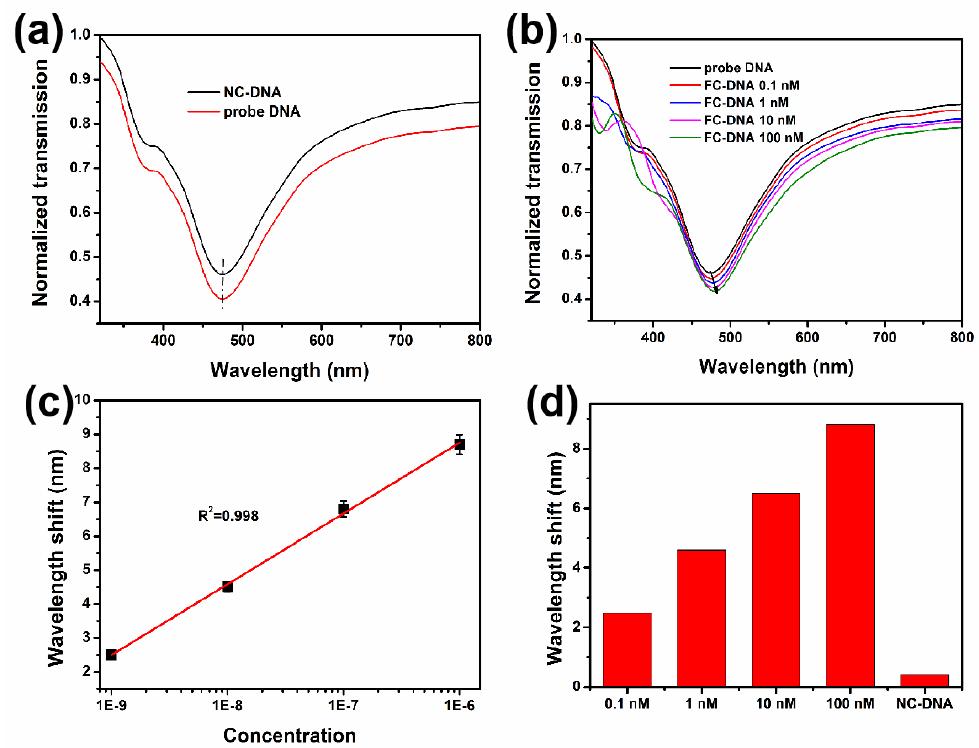
Figure 9. ( a ) LSPR spectrum of the sensor with PBASE after adding NC-DNA and probe DNA. ( b ) LSPR spectra of probe DNA and different concentrations of FC-DNA. ( c ) Resonance wavelength shift as a function of FC-DNA concentration. ( d ) Wavelength shift as a function of FC-DNA and NC-DNA, which is relative to probe DNA.